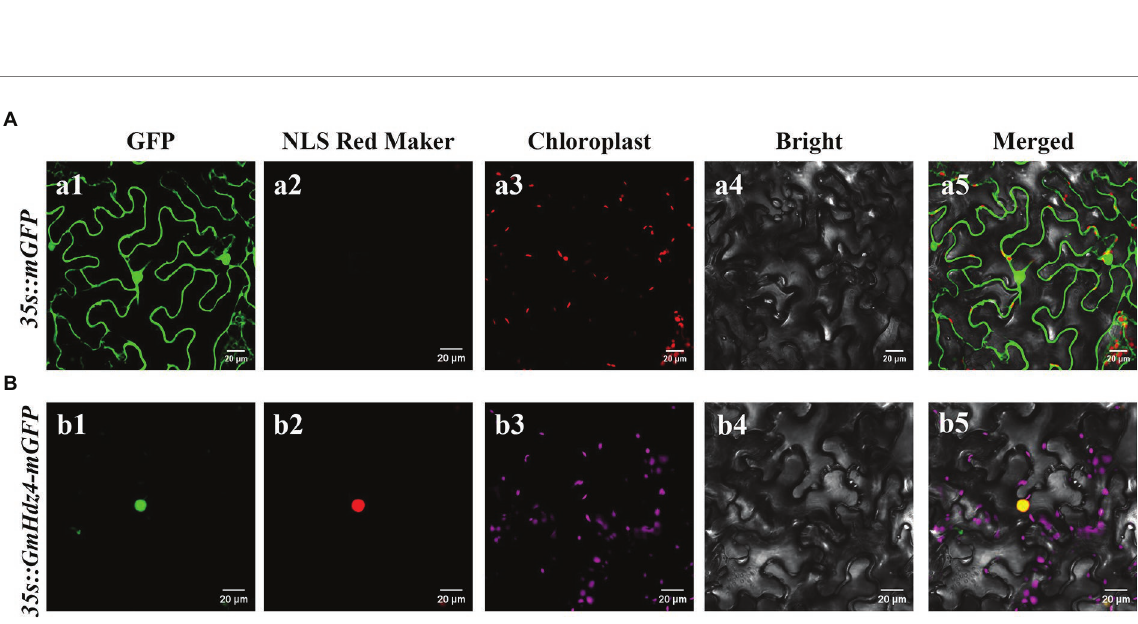
FIGURE 3 Subcellular localization analysis of GmHdz4 . The fusion plasmid (35S::GmHdz4–GFP), the negative control plasmid (35S::mGFP), and pBWD- NLSmKAT expressing an NLS Red Marker protein were transiently transformed into tobacco epidermal cells. Images were taken in the dark field for green fluorescence (a1, b1), red fluorescence (a2, b2), and chloroplast fluorescence (a3, b3), while the outline of cells (a4, b4) and merged image (a5, b5) were photographed in a bright field. Microscopy detections of 35S::mGFP were displayed in penal (A) , and the detections of 35S::GmHdz4–mGFP were displayed in penal (B) . Bars represent 20 μ